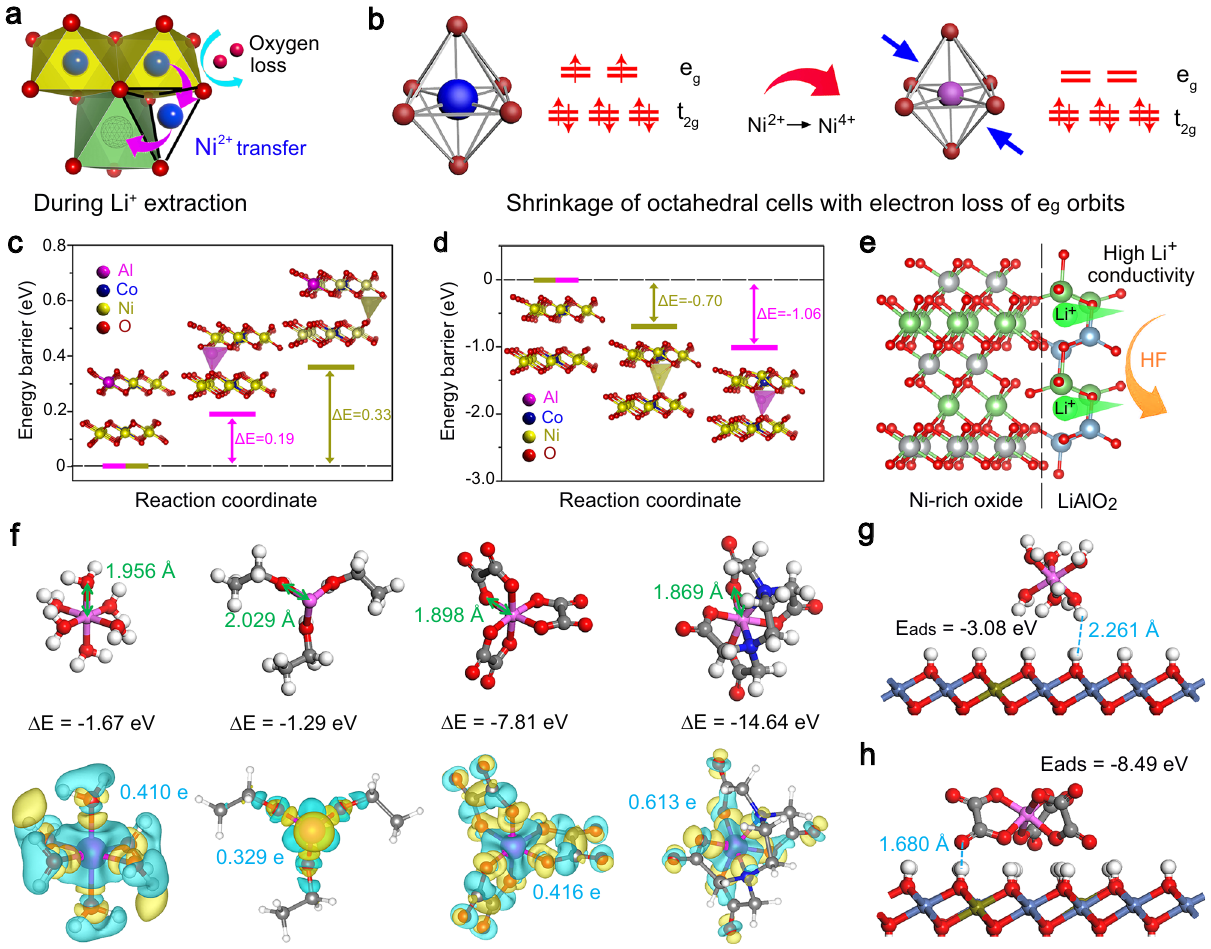
Fig. 1 Failure mechanism and modi fi cation design of Ni-rich cathode. a Ni 2 + transfer through tetrahedral interstice with loss of lattice oxygen after Li + extraction. b Shrinkage of octahedral cell of nickel ions caused by electron loss of e g orbit during oxidation. Red sphere for oxygen, blue sphere for bivalent nickel, purple sphere for tetravalent nickel, hollow sphere for Li vacancy and blue arrow for shrinkage of unit cell. c Al 3 + and Ni 2 + migration from octahedral interstices (O TM ) to tetrahedral interstices in the Li layer (T Li ) and corresponding energy barriers. d Energy barriers of Al 3 + and Ni 2 + occupying T Li sites. Purple sphere for aluminium, blue sphere for cobalt, yellow sphere for nickel and red sphere for oxygen. e Schematic of function for LiAlO 2 coating. Red sphere for oxygen, green sphere for lithium, grey sphere for nickel and blue sphere for aluminium. f Optimised con fi gurations for Al 3 + coordinated with different ligands and corresponding charge density distributions, where the binding energy ( Δ E ) and number of transferred charges between Al 3 + and ligands and coordination compound distance are included. Green and yellow denote 0.005 e of electron depletion and accumulation, respectively. Adsorption energies for coordination compounds of g Al-H 2 O and h Al-oxalate on Ni 0.9 Co 0.1 (OH) 2 surface. White, red, grey, blue and purple represent hydrogen, oxygen, carbon, nitrogen and aluminium atoms,